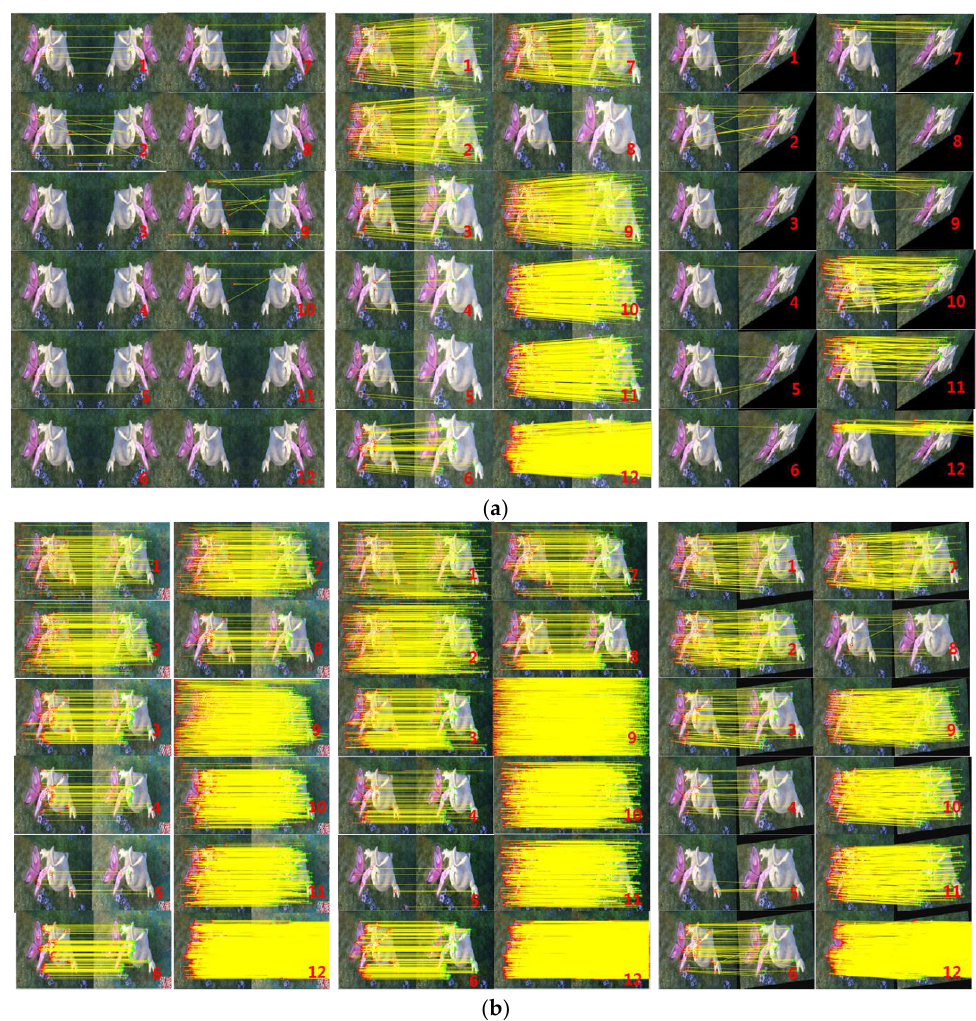
Figure 7. The results of the matching of image pairs under different feature descriptors. ( a ) The transforms from left to right: Horizontal flip; crop plus bright; Projection; ( b ) The transforms from left to right: picture add post; noise plus contrast; rotation plus crop plus noise.